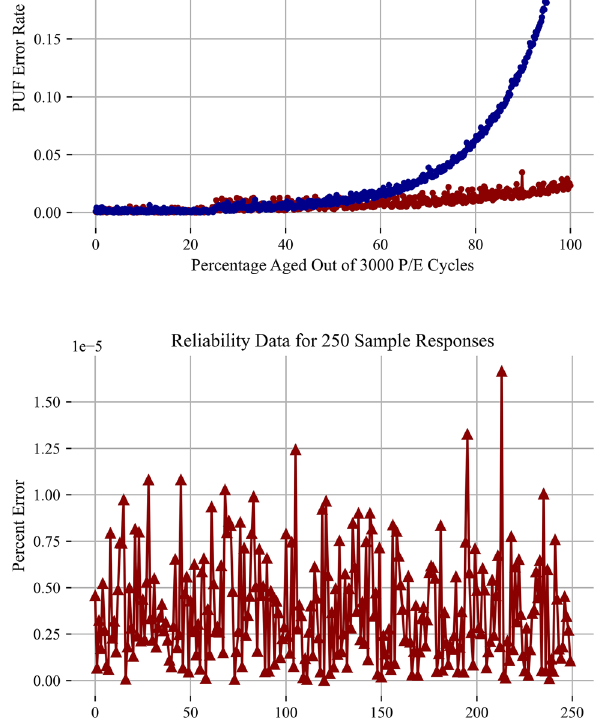
Fig. 10 Error rate vs percent- age of life used